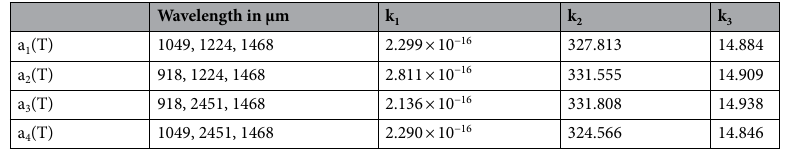
Table 2. k 1 , k 2 and k 3 values for different probability distribution function are listed. Three wavelengths are used to obtain three integral equations. The probability distributions are denoted by a 1 (T), a 2 (T), a 3 (T) and a 4 (T) corresponding to a set of